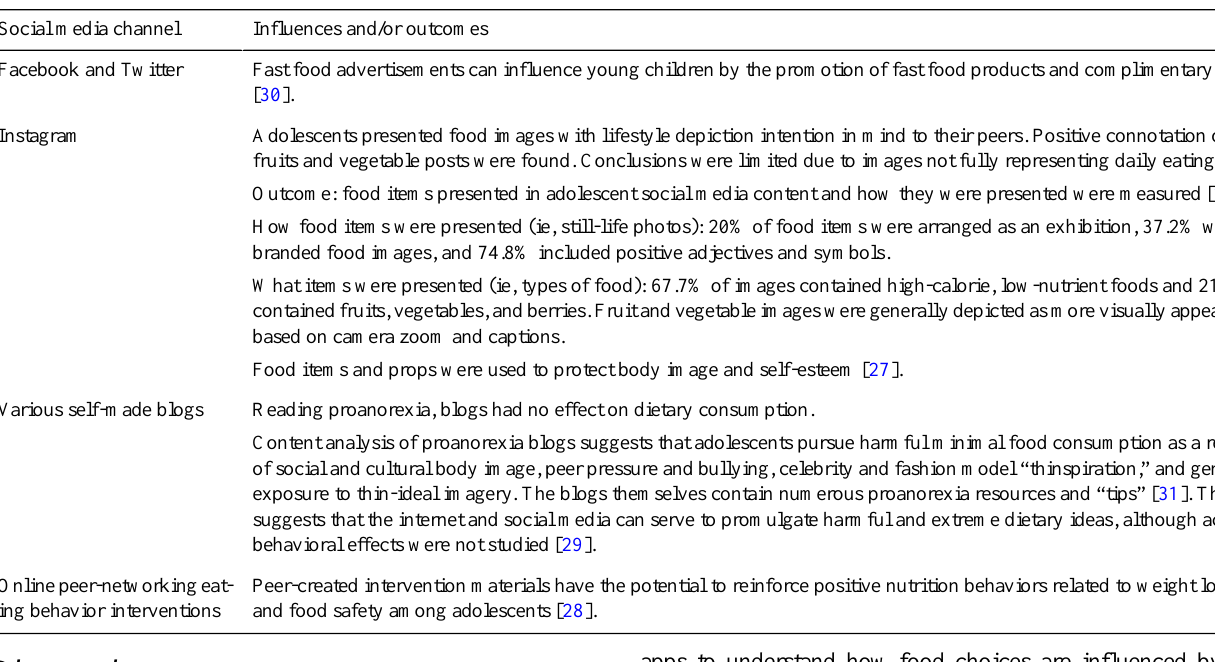
Table 2. Influences and eating behavior outcomes by social media channel. Influences and/or outcomesSocial media